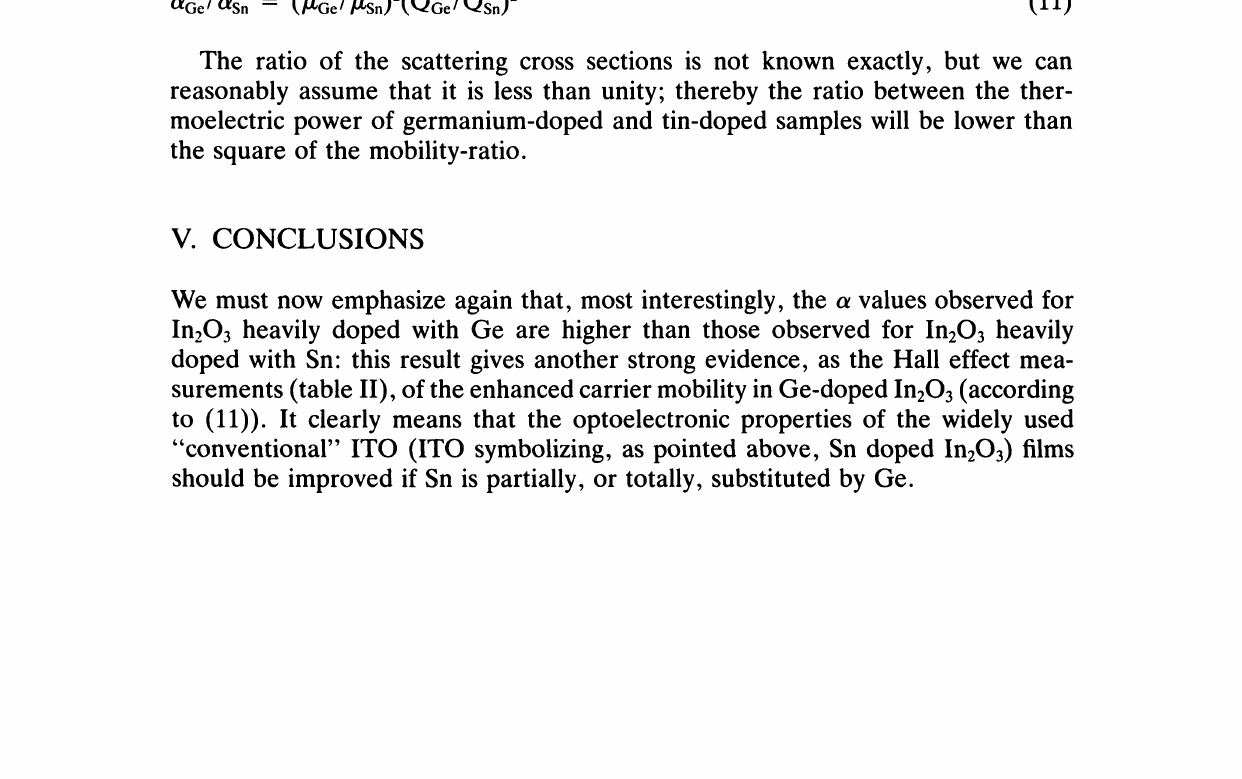
FIGURE 2 Dependence of the thermoelectric power on the electron density in undoped and Sn or Ge doped In203 ceramics at 300K. The sample symbolization is similar to that depicted in table